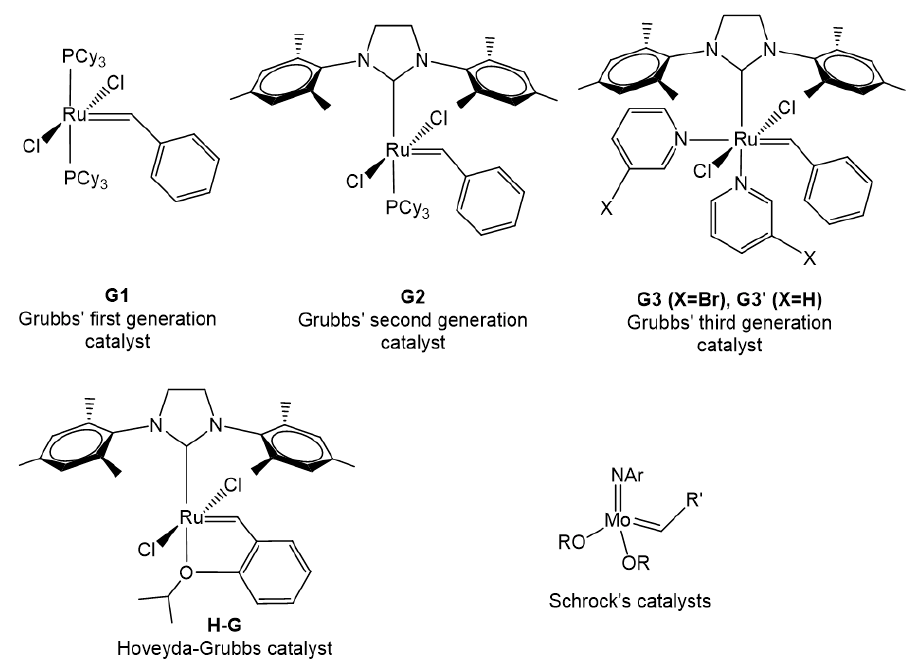
Figure 2. Grubbs’ and Schrock’s catalysts.